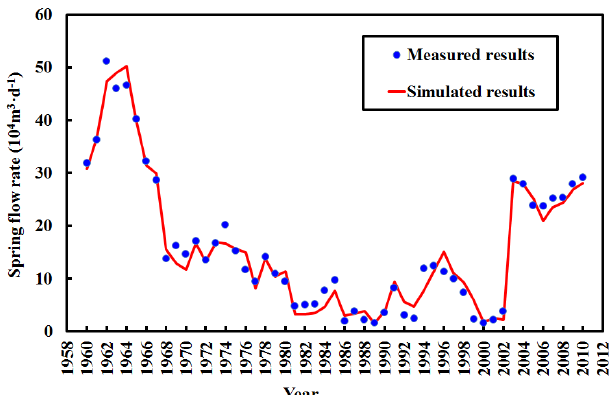
Figure 3. Comparison of measured and simulated spring flow